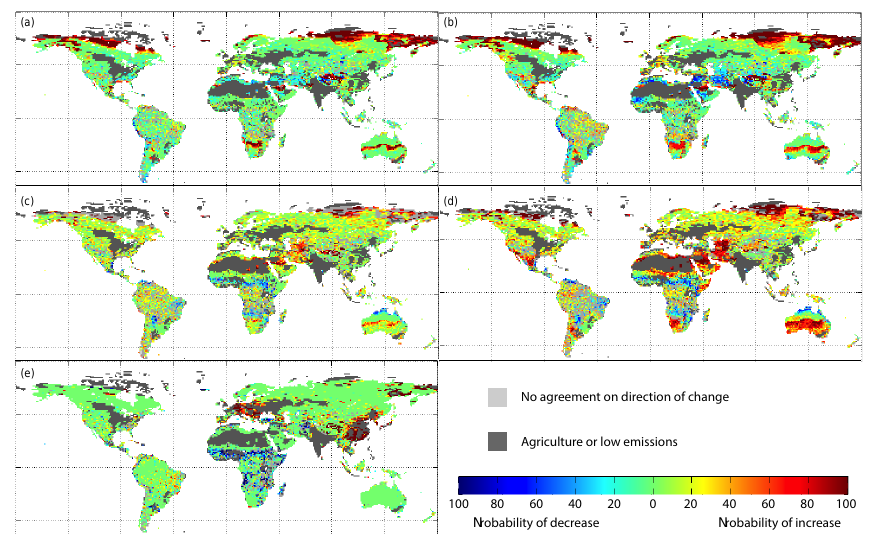
Figure 8. As previous figure, but for emissions changes due to single driving factors. (a, b) climate effect, (c, d) CO 2 effect, (e) population effect; (a, c) RCP4.5, (b, d)